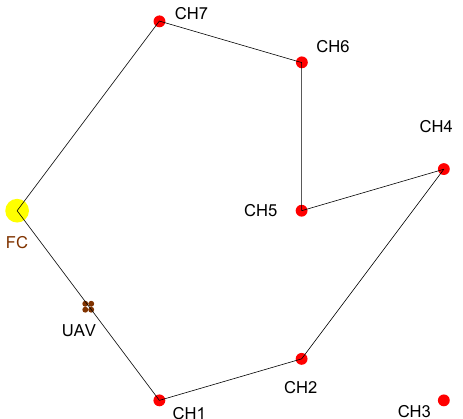
Figure A4. The whole multi-robot system consists of a fusion center (FC) where the UAV starts its route and 7 cluster head (CH) robots around FC. The red circles show the locations of the cluster head (CH) robots in their robot cluster. The UAV uses an optimal strategy such that it visits CH 1, CH 2, CH 4, CH 5, CH 6, and CH 7 in order (The path has a length of 220 m). With respect to the initial position at ξ 0 = ( 0,0 ) , the positions of the CH robots are ( ξ 1 , ξ 2 , ξ 3 , ξ 4 , ξ 5 , ξ 6 , ξ 7 ) = (( 24, − 32 ) , ( 48, − 25 ) , ( 72, − 32 ) , ( 72,7 ) , ( 48,0 ) , ( 48,25 ) , ( 24,32 )) m .